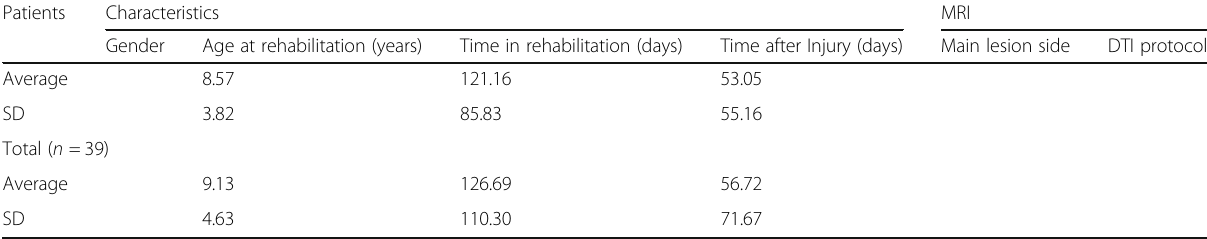
Table 1 Patients and diffusion tensor imaging characteristics (Continued) Patients